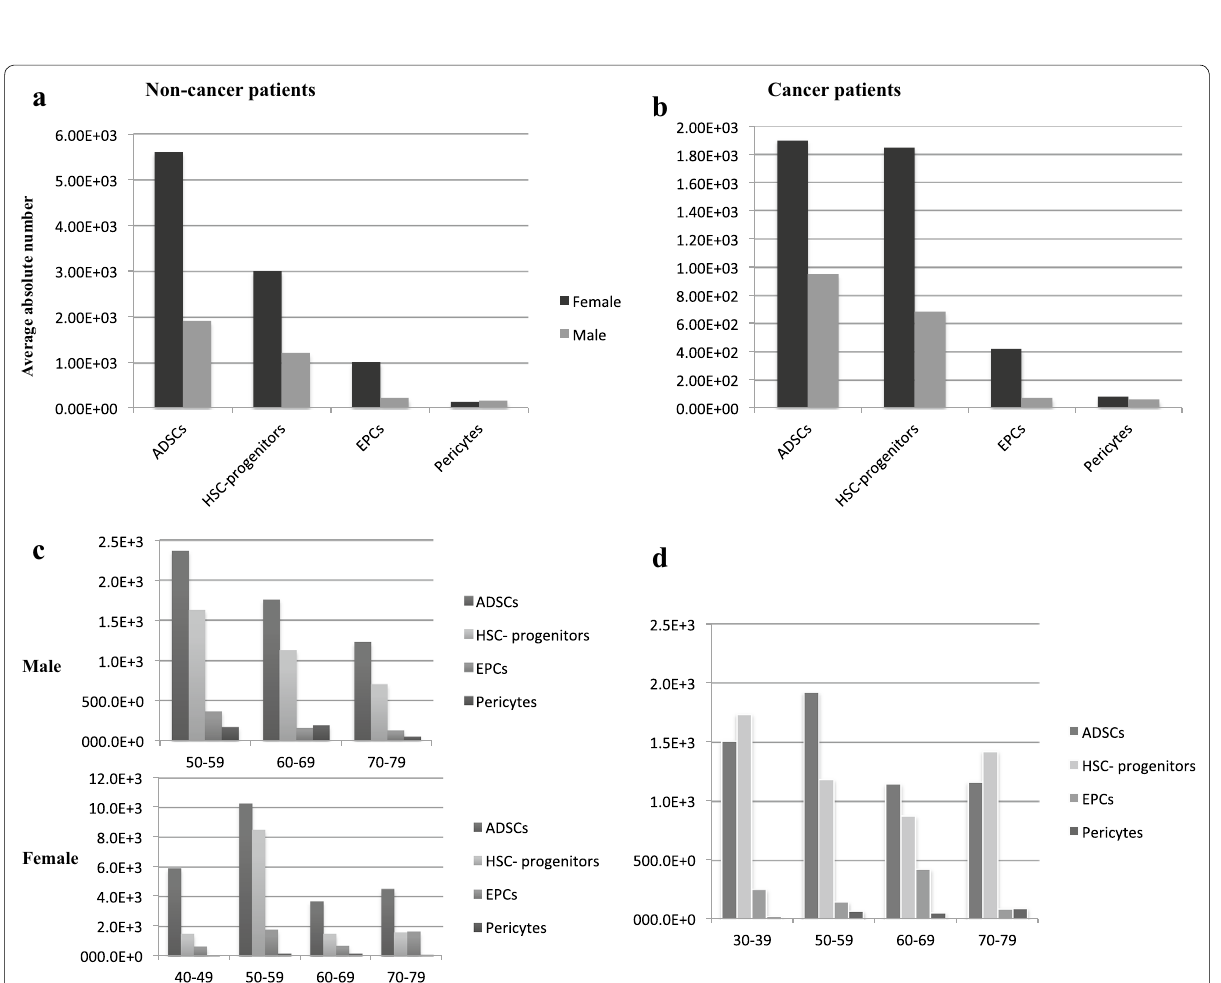
Fig. 3 Evaluation of SVF yields based on gender, cancer and age. a Trends between the total numbers of 4 cell subsets freshly isolated from fat among female and male participants in ( a ) non-cancer patients versus ( b ) cancer patients can be seen by comparing the height of the bars. c The mean number of the subsets analyzed per age in males (upper figure) versus females (lower figure) in non-cancer patients is shown as the height of the bars. (Note that the age groups with less than one patient are not included in the analysis.) d The mean number of the subsets (the height of the bars) is compared for the various different age groups (the X-axis) for observing